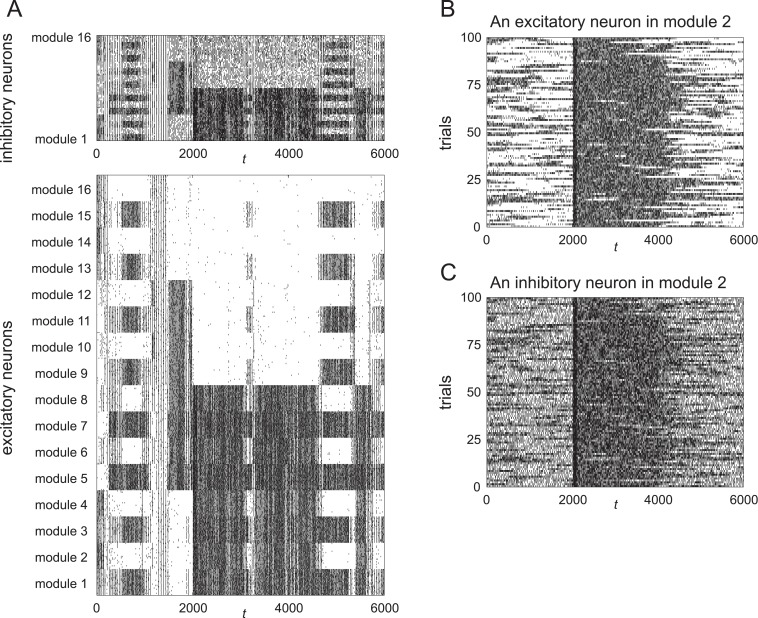
Spike activity of the neurons.(A) Raster plot of spike activity obtained from the dynamics for REI = 0.98 shown in Fig 3D. To reduce the volume of data, we show only the firings of 20 randomly chosen excitatory neurons and 5 randomly chosen inhibitory neurons in each module. (B) Spikes of a typical excitatory neuron in the second module for 100 simulated trials. (C) Spikes of a typical inhibitory neuron in the second module for 100 simulated trials.